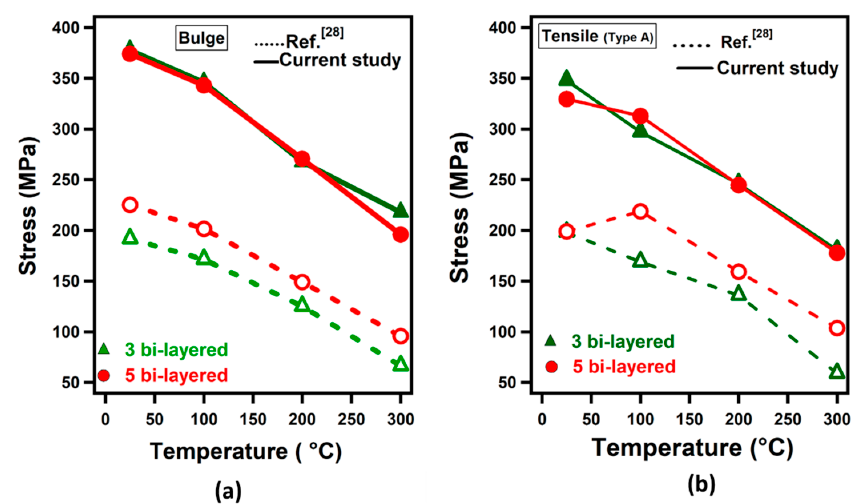
Figure 14. Failure stress-temperature curves: ( a ) Bulge test results at a strain rate of 0.0013 / s and ( b ) tensile test results at a strain rate of 0.013 / s and 0.017 / s of the current study and previous study by authors [28].